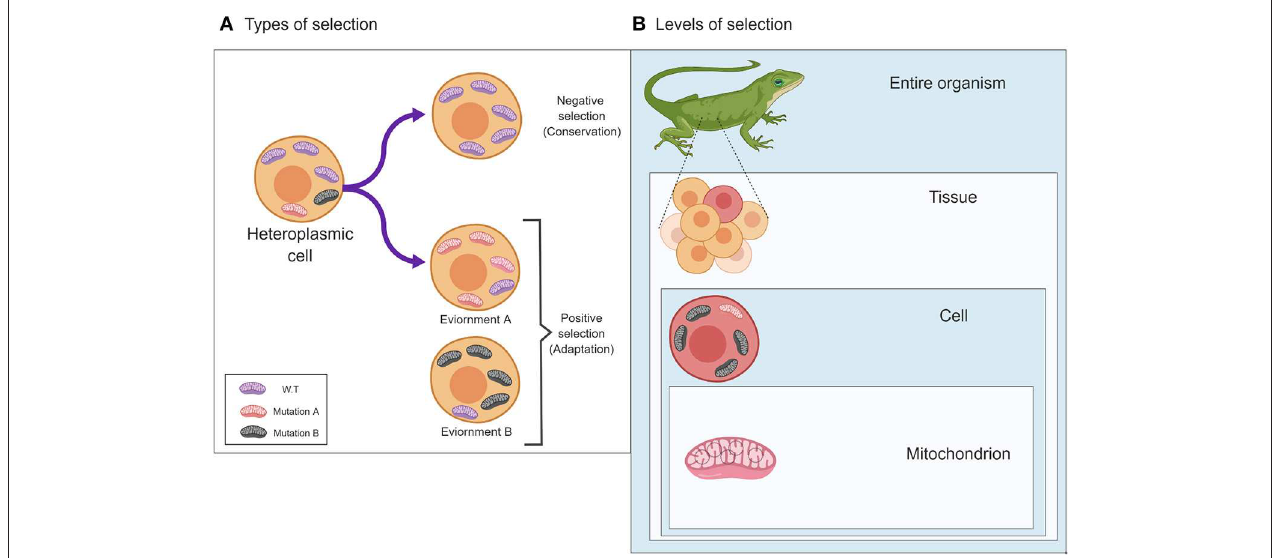
FIGURE 1 | The two main types of selection, Negative and Positive, and their effects on patterns of mitochondrial genetic variability. (A) Different types of selection (negative or positive) affect the pattern of mitochondrial mutations in response to different environments (lower panels) or will undergo a selective sweep (negative selection to maintain function (upper panel). (B) The different levels in which selection may act on the mitochondria, i.e., (down-up) the single mitochondrion, cells and the entire organism. The figure was designed using ©